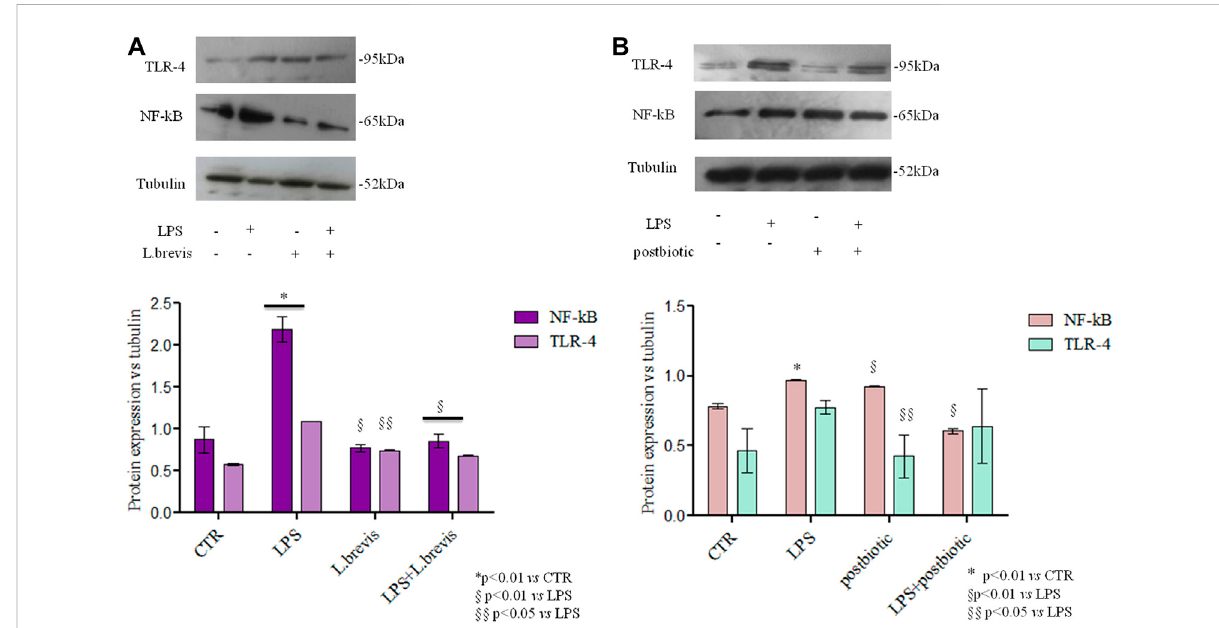
FIGURE 7 TLR-4 and NF-kB protein expression analyzed by western blotting in differentiated Caco-2 cells treated with (A) Cells insulted with LPS were treated with L.brevis (B) Cells insultedwith LPS weretreated with postbiotics secreted by L. brevis (and partially puri fi edas described inthe text). The intensityofthebandswasnormalizedinrespecttotubulininthedensitometryreportedasaverageandSD.Studentt-testwasusedfortheevaluation of statistical differences and indicated as * p < 0.01 vs. CTR, § p < 0.01 vs. LPS and §§ p < 0.05 vs.